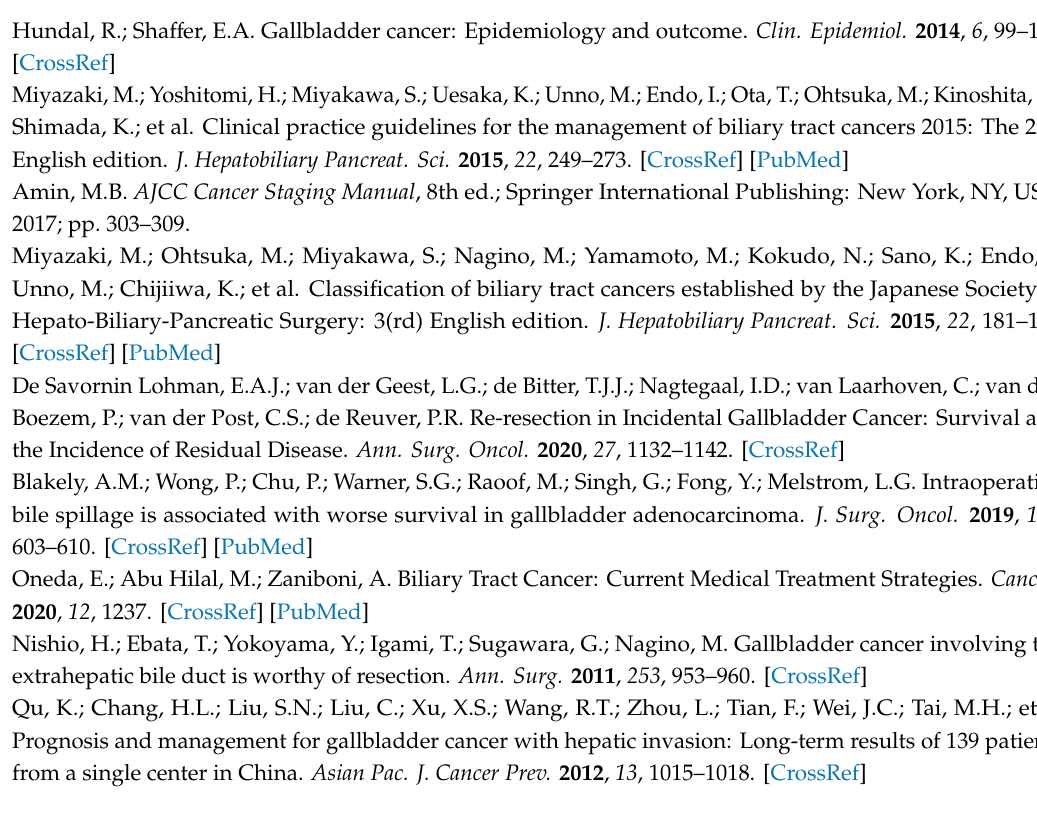
Figure S1: (A): Overall survival rate based on degree of liver invasion, (B): Overall survival rate based on degree of hepatoduodenal ligament invasion, Figure S2: Recurrence-free survival (RFS) rate depending on the number of prognostic factors in patients with stage 3 / 4 gallbladder cancer without distant metastasis. Figure S3: (A): The receiver operating characteristic analysis of age with death used as an event, (B): The receiver operating characteristic analysis of blood loss with death used as an event, (C): The receiver operating characteristic analysis of surgery time with death used as an event, Table S1: (A): Number at risk, median survival time, and five-year survival rate based on degree of liver invasion, (B): Number at risk, median survival time, and five-year survival rate based on degree of hepatoduodenal ligament invasion. Table S2: (A): Number at risk, median survival time, and five-year survival rate based on the number of prognostic factors predicted preoperatively in patients with stage 3 / 4 gallbladder cancer without distant metastases, (B): Number at risk, median survival time to recurrence, and five-year recurrence-free survival rate based on the number of prognostic factors predicted preoperatively in patients with stage 3 / 4 gallbladder cancer without distant metastases, Table S3: Characteristics of